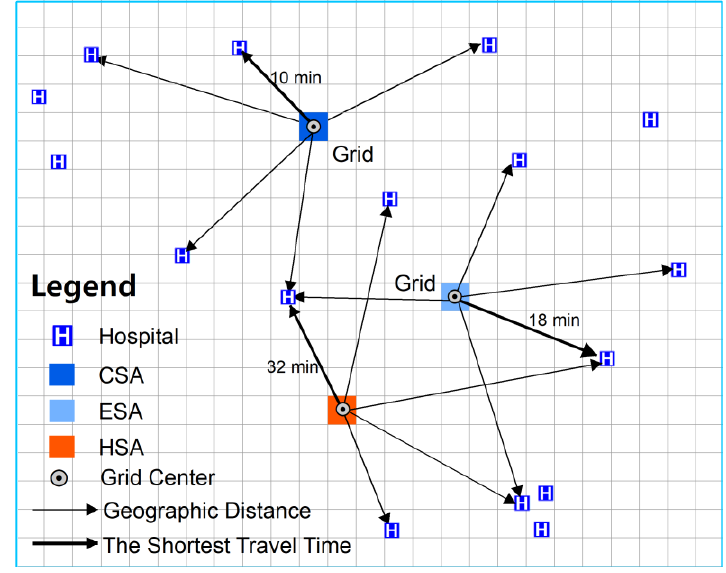
Figure 2. Calculation of grid-to-level healthcare spatial accessibility.